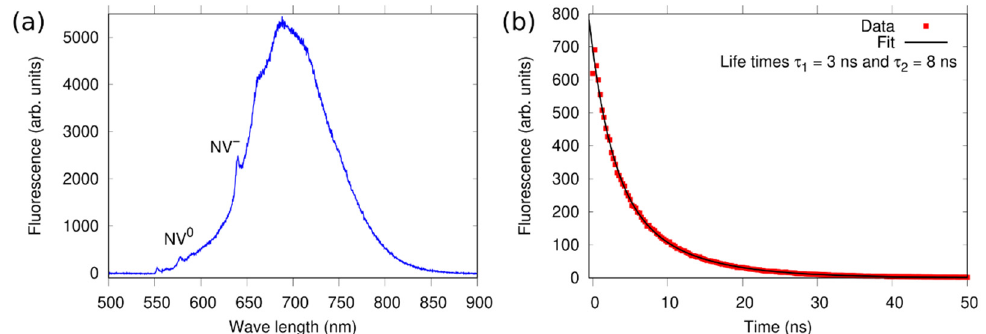
Figure 6. ( a ) Typical fluorescence spectrum from an exemplarily chosen single pillar, where the zero-phonon line of NV - centers at 637 nm is clearly visible. The line at 575 nm suggests the presence of a small number of NV 0 centers. ( b ) Lifetime measurement of the NVs’ excited state in a pillar, revealing a bi-exponential decay with time constants τ 1 = 3 ns and τ 2 = 8 ns. The bulk areas of both samples show similar spectra and lifetime values (data not shown).